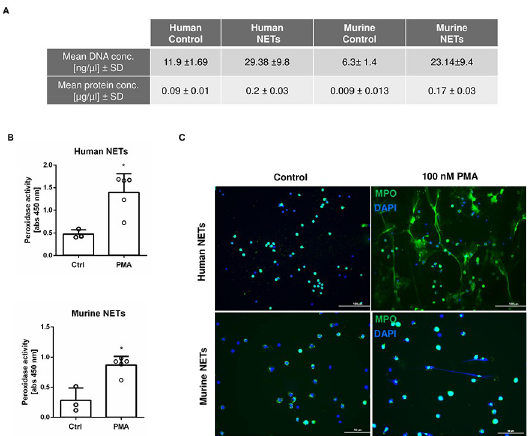
Fig 1. Induction and validation of NETs release by human and murine neutrophils. (A) Human and murine neutrophils (2 × 10 6 ) were stimulated with 100 nM PMA for 3.5 h. Then, the DNA and protein contents of NETs- enriched supernatants were quantified (n = 5). Unstimulated cells (n = 3) served as controls. (B) Peroxidase activity was quantified in the supernatant collected from unstimulated (n = 3) or PMA-stimulated neutrophils (n = 5), respectively. (C) To confirm NETs formation, neutrophils (1.5 × 10 5 ) were seeded on polylysine-coated coverslips and stimulated with 100 nM PMA for 3.5 h. Cells were further stained with anti-MPO antibody ( green ) and counterstained with DAPI ( blue ). Results of three independent experiments are depicted. � P < 0.05 (Mann-Whitney test).